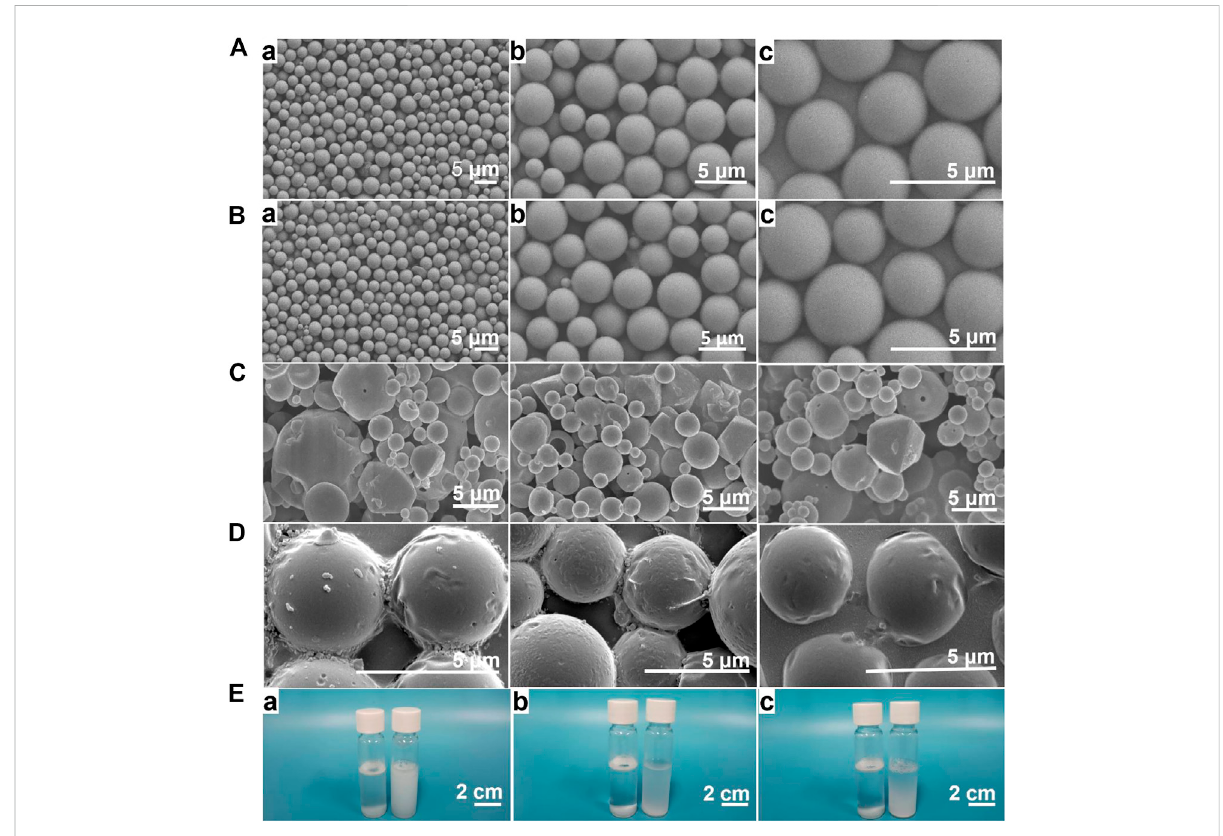
FIGURE 3 (A) PLGA microcapsule prepared with premixed membrane emulsi fi cation method. Lidocaine@PLGA microcapsule prepared with (B) and without (C) premixedmembraneemulsi fi cationmethodbyelectronmicroscopeat(a)1000x,(b)3000x,or(c)5000x. (D) Themorphologychangeof Lidocaine@PLGA microcapsule after ultrasound process. (E) Optical photographs of 3 mg/ml of Lidocaine@PLGA microcapsule with (right) and without (left) premixed membrane emulsi fi cation method in water after standing for (a) 0 h, (b) 6 h, and (c) 12 h.